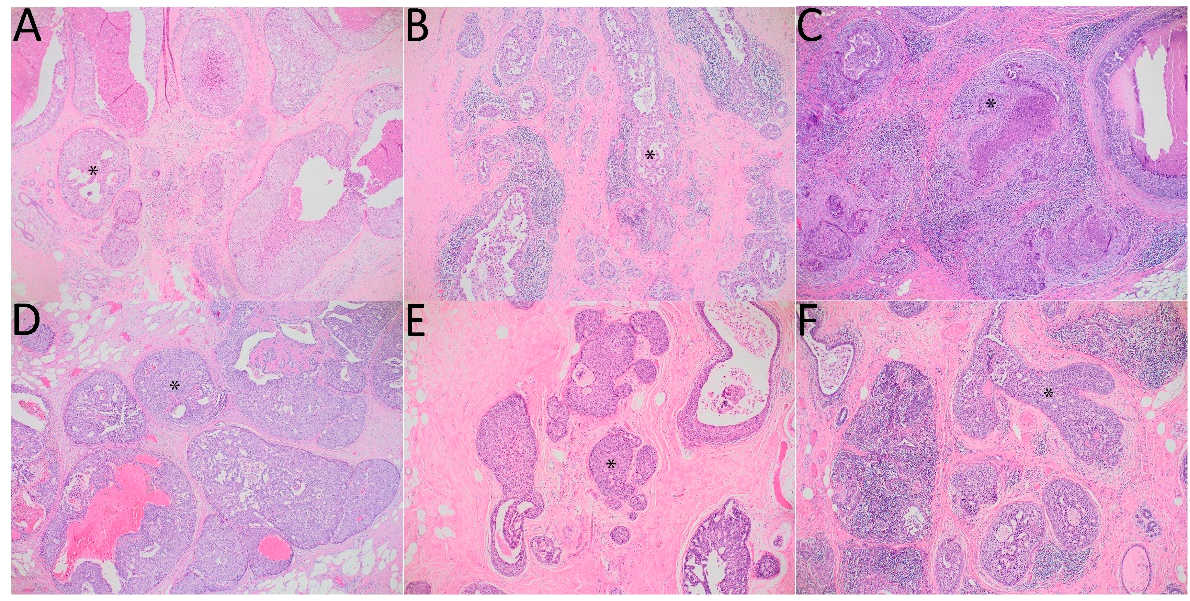
Figure 1. DCIS with signs of neoductgenesis. Hematoxylin-eosin stain. Magnification 100 × . An asterisk (*) in each panel was added to indicate an example of the pathological duct. ( A ): focal concentration of duct-like structures and focal loss of normal ductal-lobular architecture–1 point, mild periductal lymphocytic infiltration–1 point, little fibrosis-like thickening of the periductal stroma–1 point, total score–3 points; ( B ): focal concentration of duct-like structures and focal loss of normal ductal-lobular architecture–1 point, intense periductal lymphocytic infiltration–2 points, no fibrosis-like thickening of the periductal stroma–0 points, total score: 3 points; ( C ): focal concentration of duct-like structures and focal loss of normal ductal-lobular architecture–1 point, no periductal lymphocytic infiltration–0 points, much fibrosis-like thickening of the periductal stroma–2 points, total score–3 points; ( D ): general concentration of duct-like structures and loss of normal ductal-lobular architecture–2 points, mild periductal lymphocytic infiltration–1 point, little fibrosis-like thickening of the periductal stroma–1 point, total points–4 points; ( E ), ( F ): focal concentration of duct-like structures and focal loss of normal ductal-lobular architecture–1 point, intense periductal lymphocytic infiltration–2 points, much fibrosis-like thickening of the periductal stroma–2 points, total score–5 points.